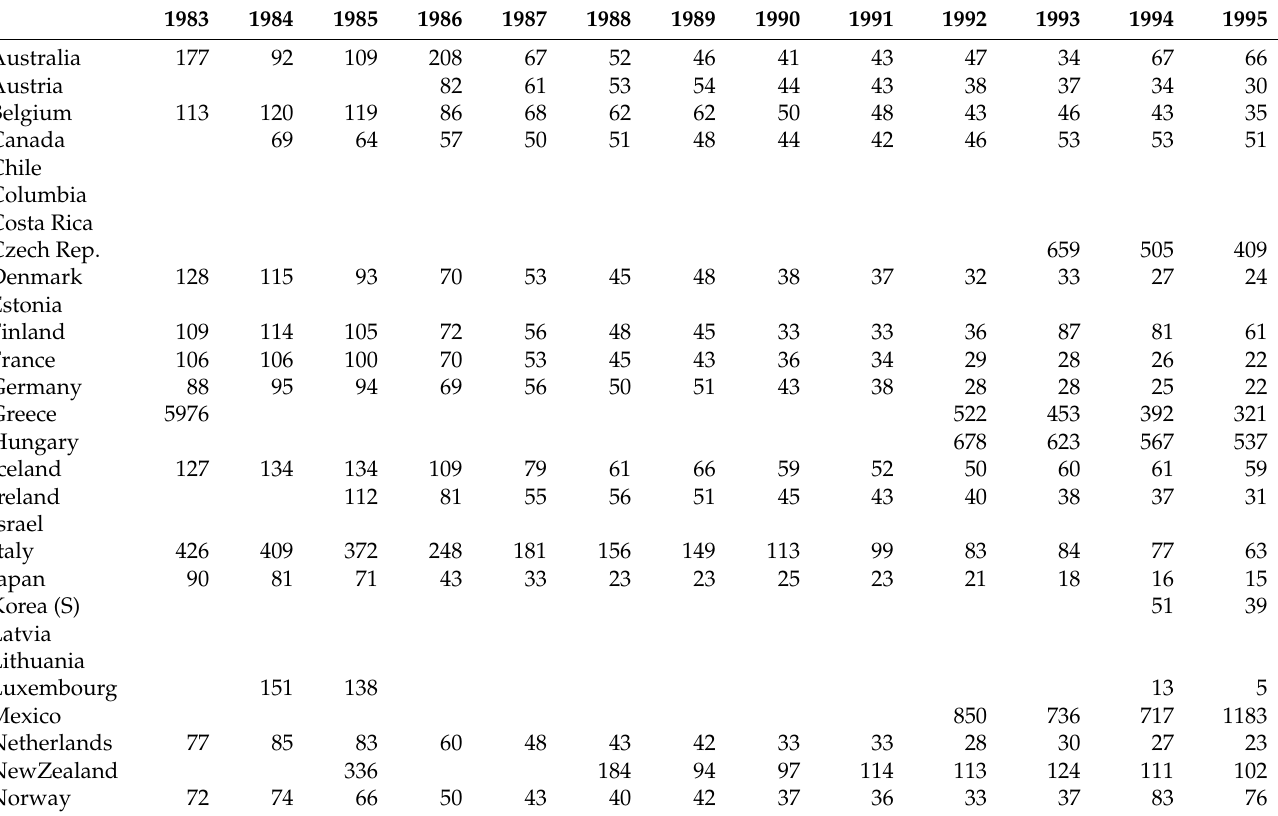
Table 1. RTPLS Estimates for d (Life expectancy in days)/ d (per capita insurance premiums in US